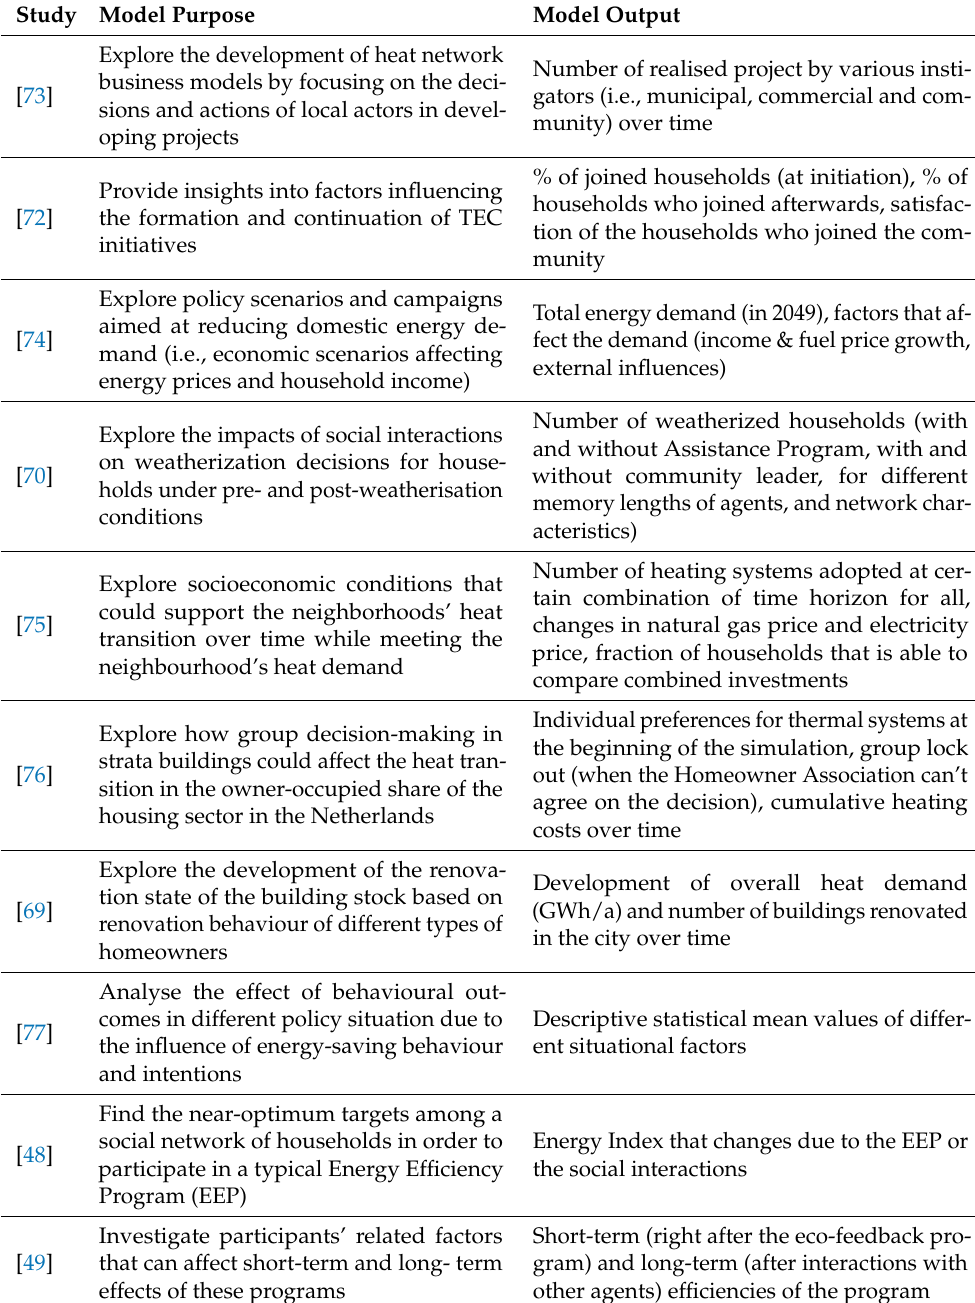
Table 2. Model purposes and model outputs of the selected studies—Exploratory